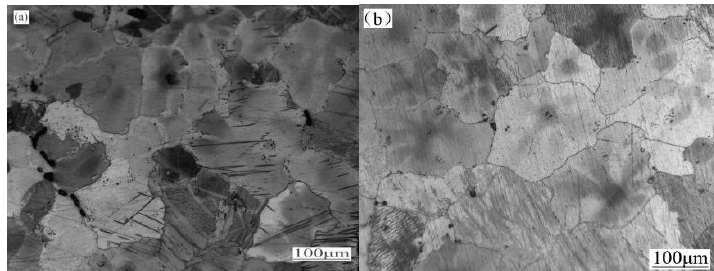
Figure 2. Optical microstructures of ZK60 magnesium alloy ( a ) as-cast ( b ) as-homogenization.